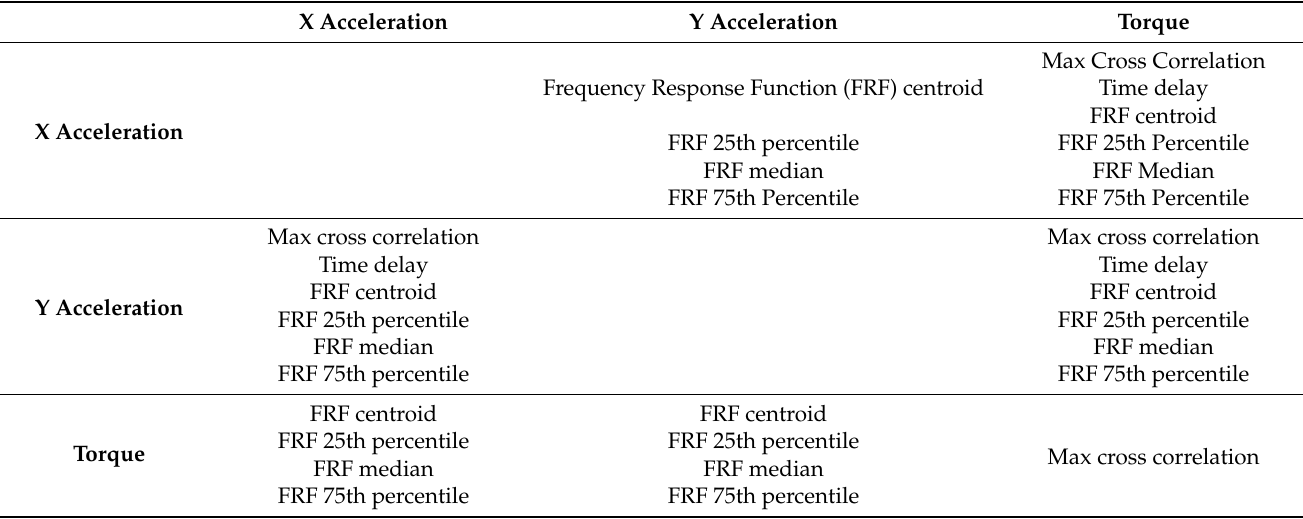
Table 3. Features based on channel pairs